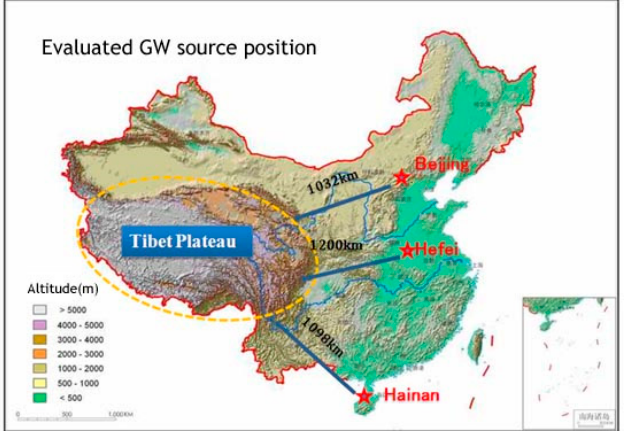
Figure 4. Diagram of evaluated GW source position located at the edge of TP.